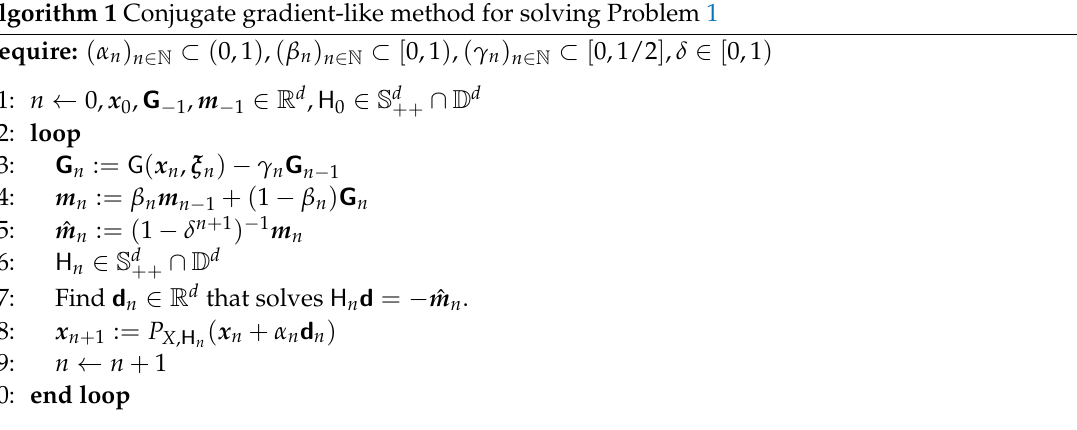
Algorithm 1 Conjugate gradient-like method for solving Problem